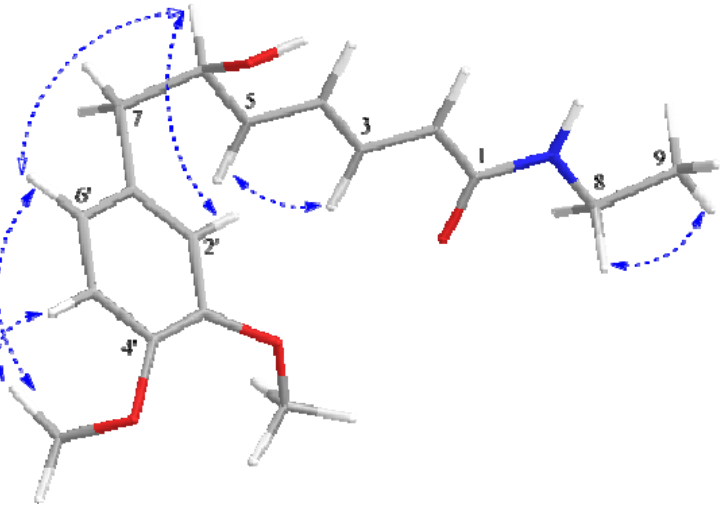
Figure 3. Selected NOESY correlation of ( − )-kunstleramide ( 1